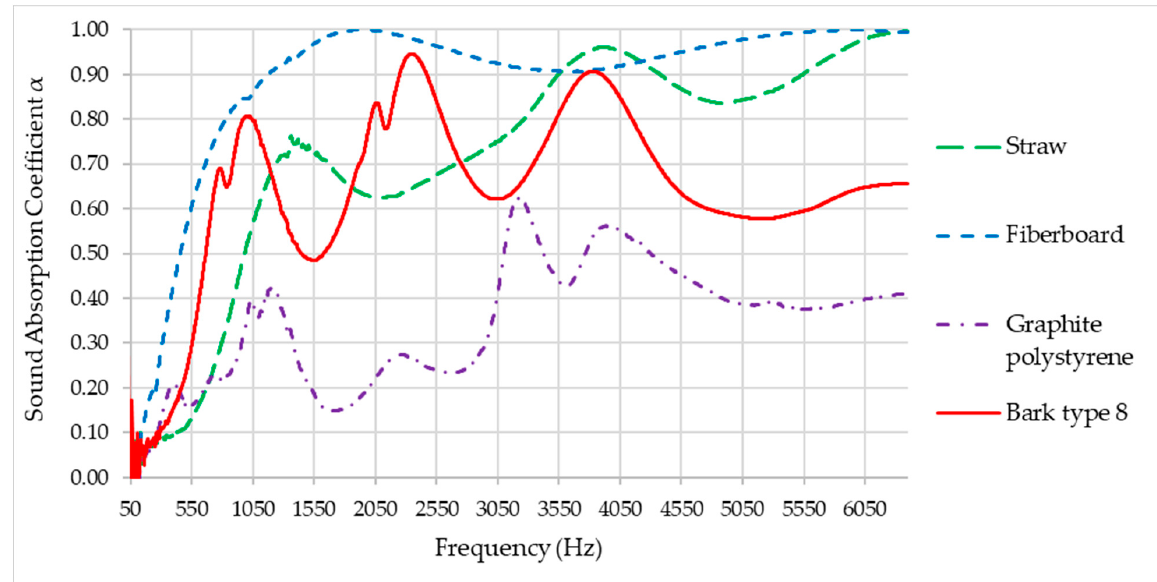
Figure 7. Comparison of frequency dependence of the sound absorption coefficient of straw, graphite polystyrene, fiberboard and bark type 8.